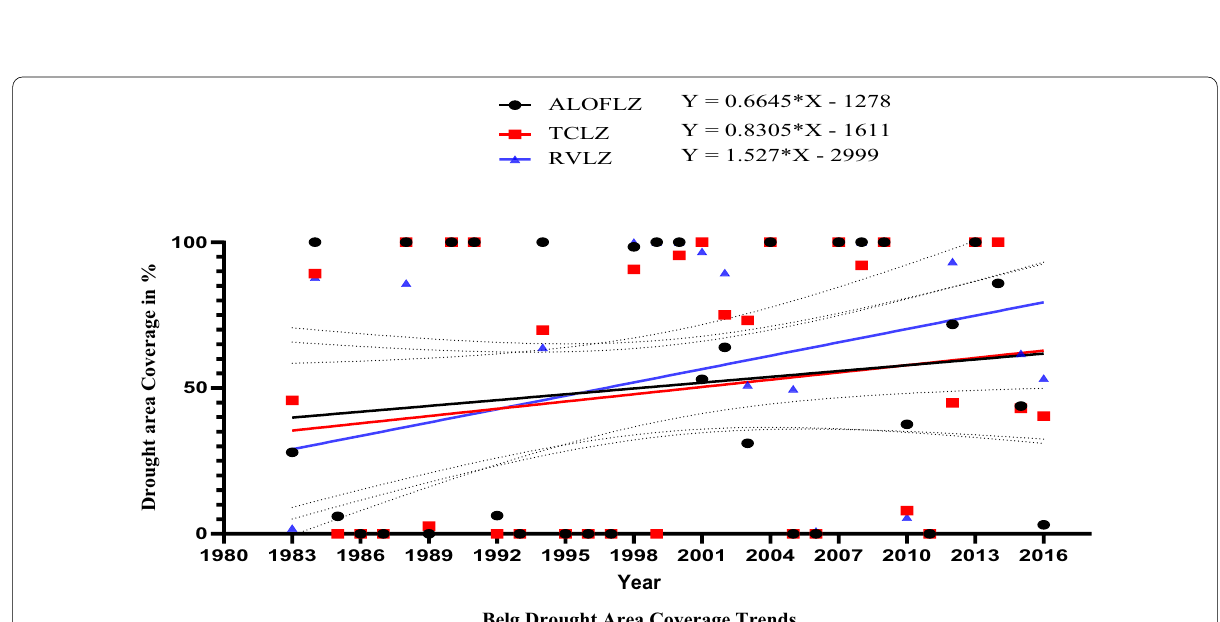
Fig. 4 The spatial drought trends in % of area coverage from 1983 to 2016 using GraphPad Prism in Belg